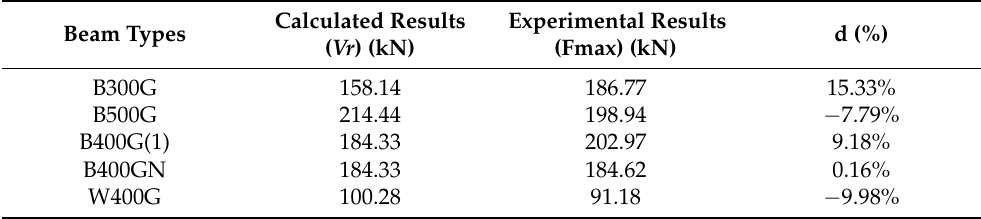
Table 4. Comparison between the predicted cross-section stiffness and experimental